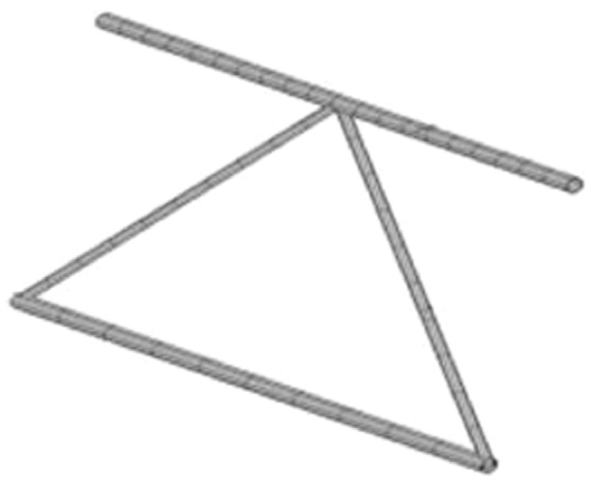
Figure 6: The model of column support.